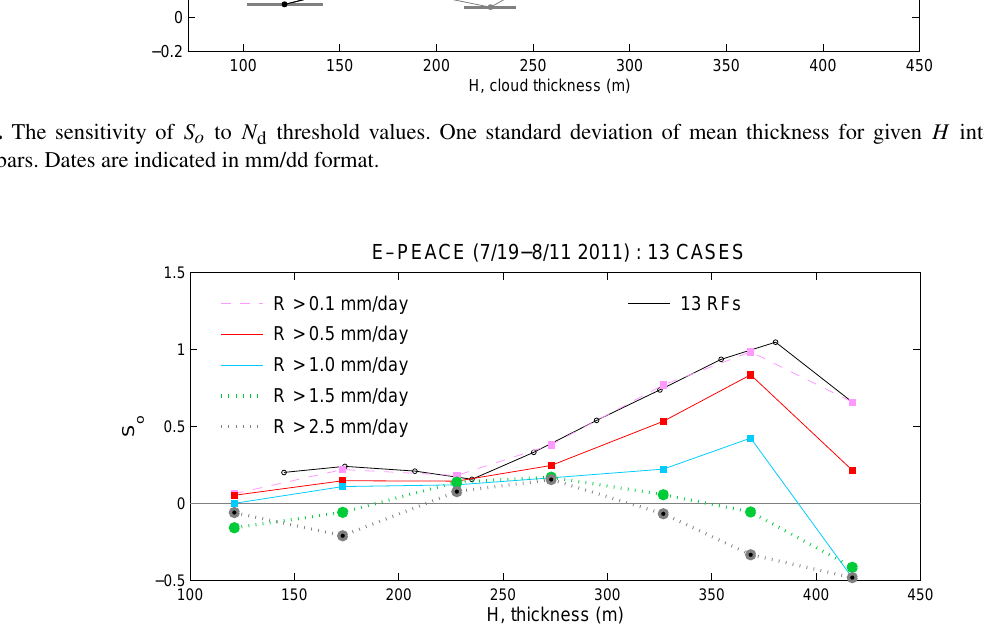
Figure B2. H -dependent precipitation susceptibility as a function of R threshold values. Dates are indicated in mm/dd